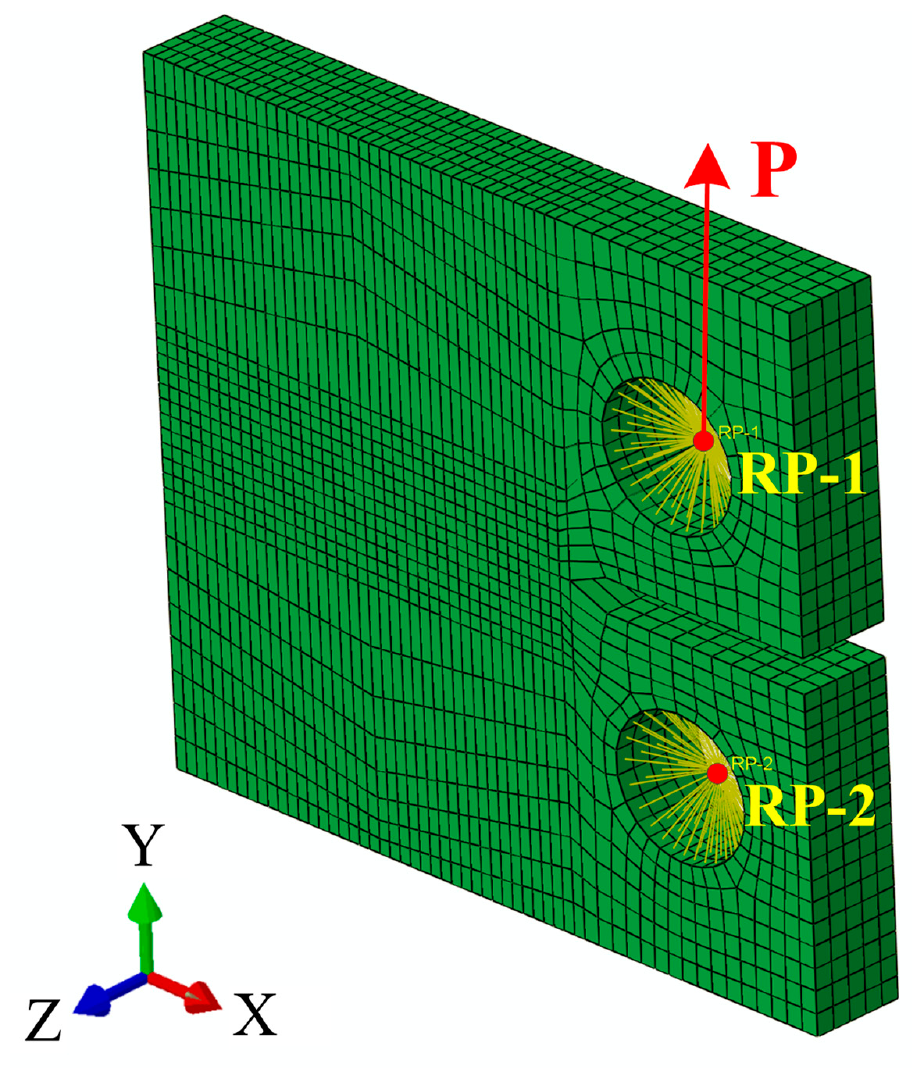
Figure 7. FEM of CT specimen.